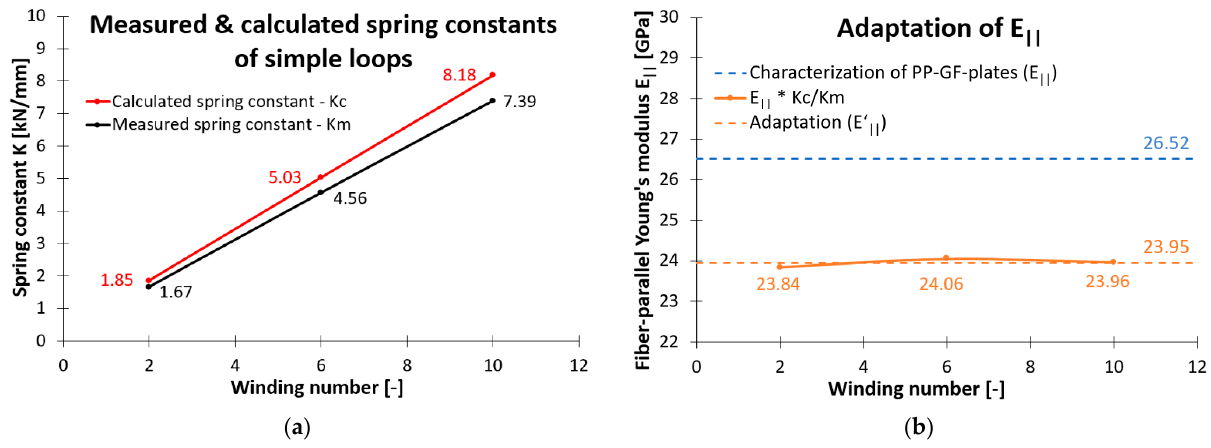
Figure 14. ( a ) Comparison of measured and calculated spring constants; ( b ) Corresponding adaptation of 𝐸 || .